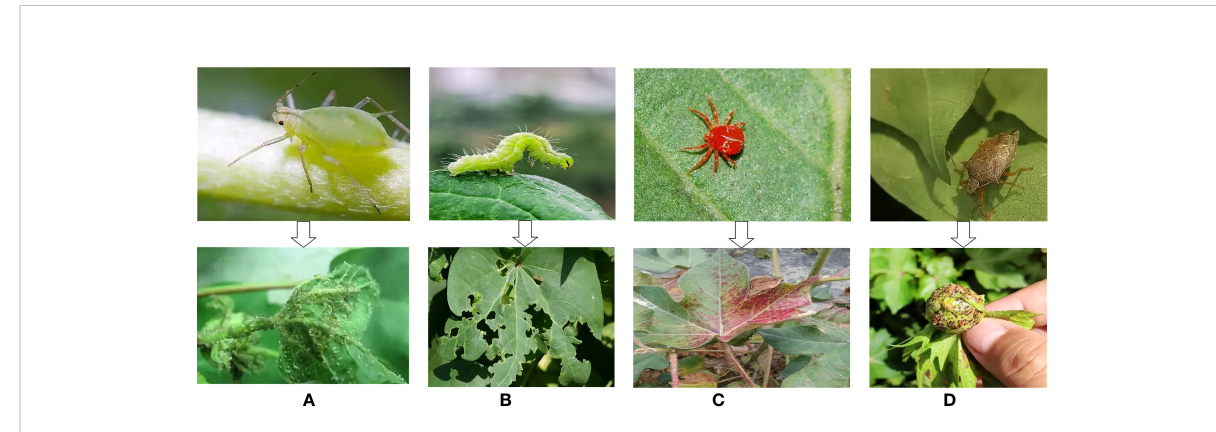
FIGURE 1 The main pests of cotton in Xinjiang and their harm to cotton. (A) Cotton aphid, (B) cotton bollworm, (C) cotton red spider, (D) cotton plant